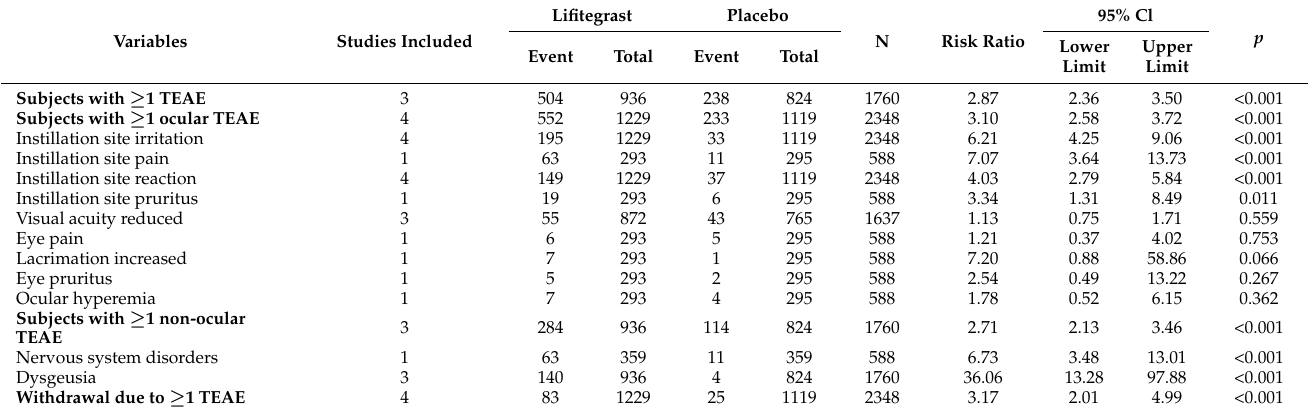
Table 2. Safety profile of